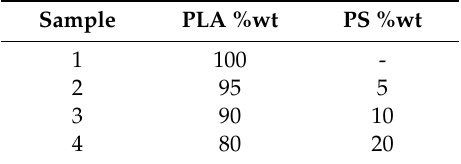
Table 4. Formulation of PLA / PS acrylic copolymer-based product cast films for the study of interactions.